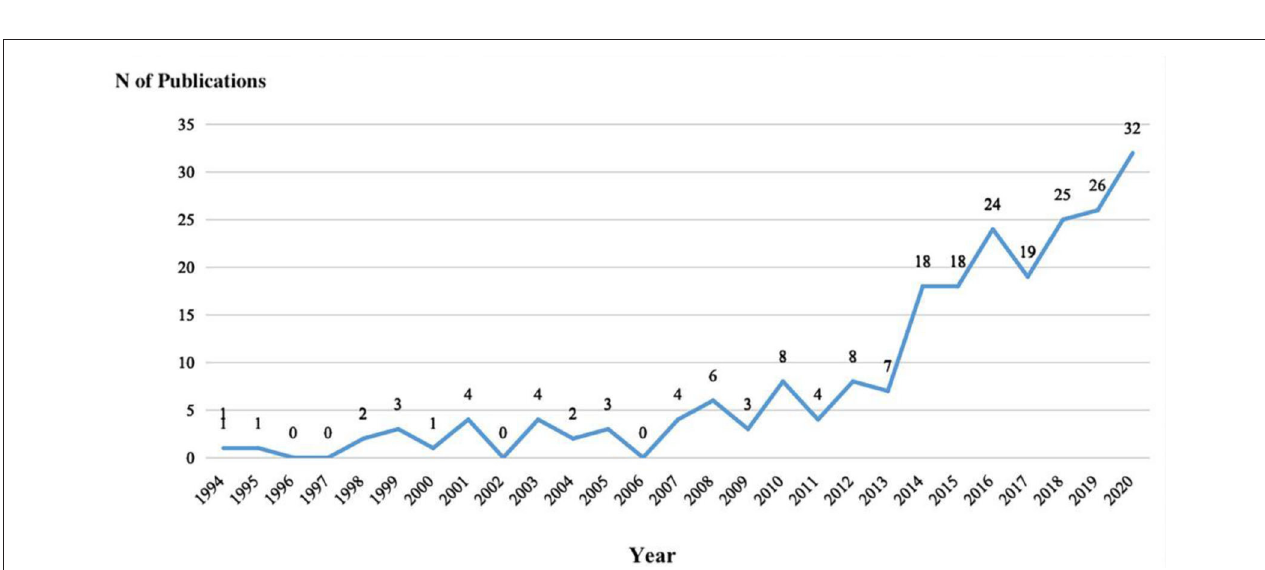
FIGURE 2 | Trend in the number of publications on psychache in suicidology included in WoS database from 1994 to